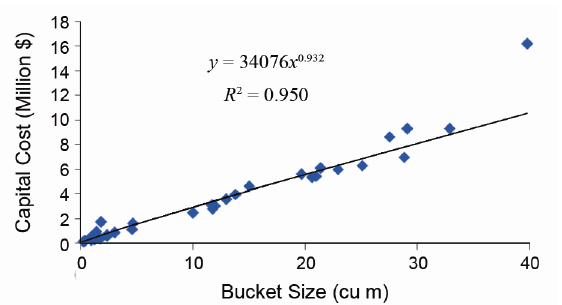
Fig. 2. UVER result for capital cost